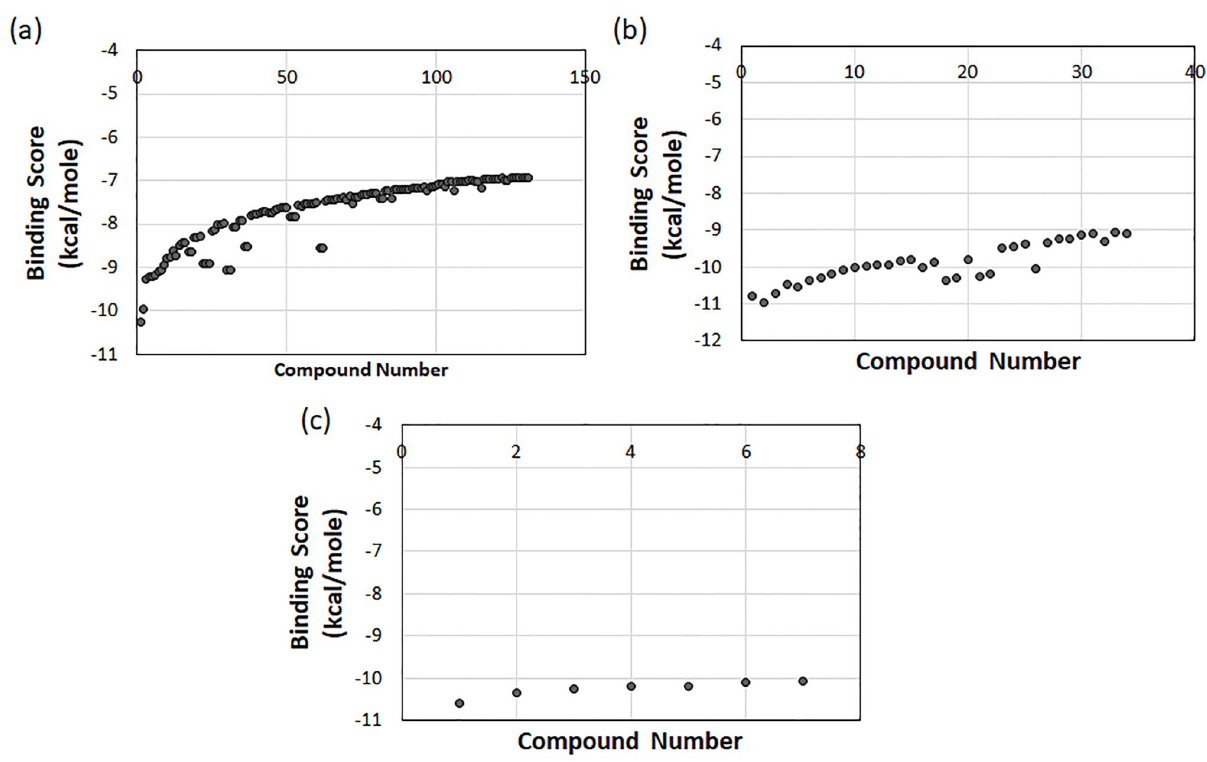
Fig 3. Binding scores of compounds were obtained via three different accuracy levels applied during the structure-based virtual screening process. (a) HTVS, (2) Glide SP, and (c) Glide XP.